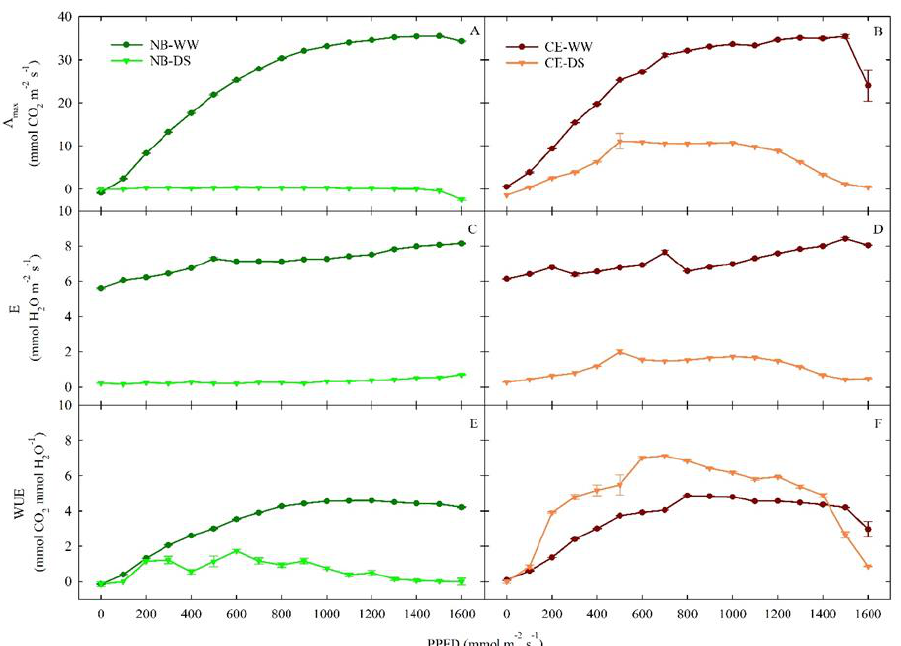
Figure 4. Responses of photosynthetic capacity (A max , ( A , B )), transpiration ( C – E ), and water use efficiency (WUE, ( E , F )) to changes in photosynthetic photon flux density (PPFD) in well-watered and drought-stressed ‘Nocellara del Belice’ (NB-WW and NB-DS, respectively) and ‘Cerasuola’ (CE-WW and CE-DS, respectively) olive trees on the 59th day of drought stress. Error bars indicate the standard errors of the means.